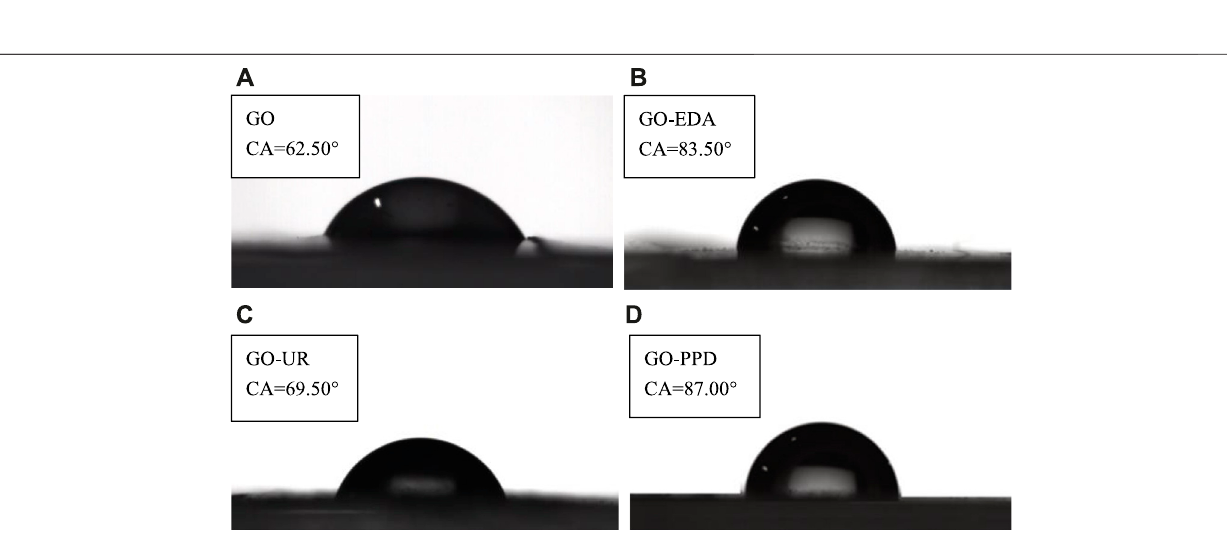
Frontiers in Chemistry |